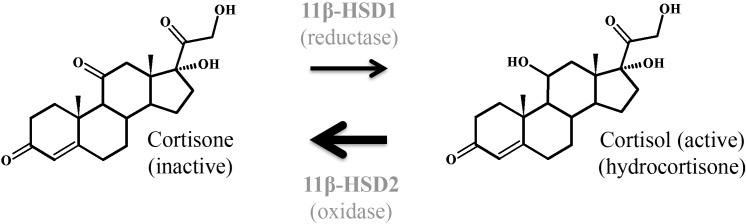
Interconversion of cortisol and the inactive metabolite cortisone by 11β-hydroxysteroid dehydrogenases type 1 and 2. 11β-HSD1 exerts mainly reductase activity in vivo, while 11β-HSD2 metabolizes the conversion of cortisol to cortisone. In human placenta, conversion from cortisol to cortisone predominates at all gestational ages, but increasing conversion of cortisone to cortisol in homogenized human placental tissue toward term indicates a predominant reductase activity of 11β-HSD1.